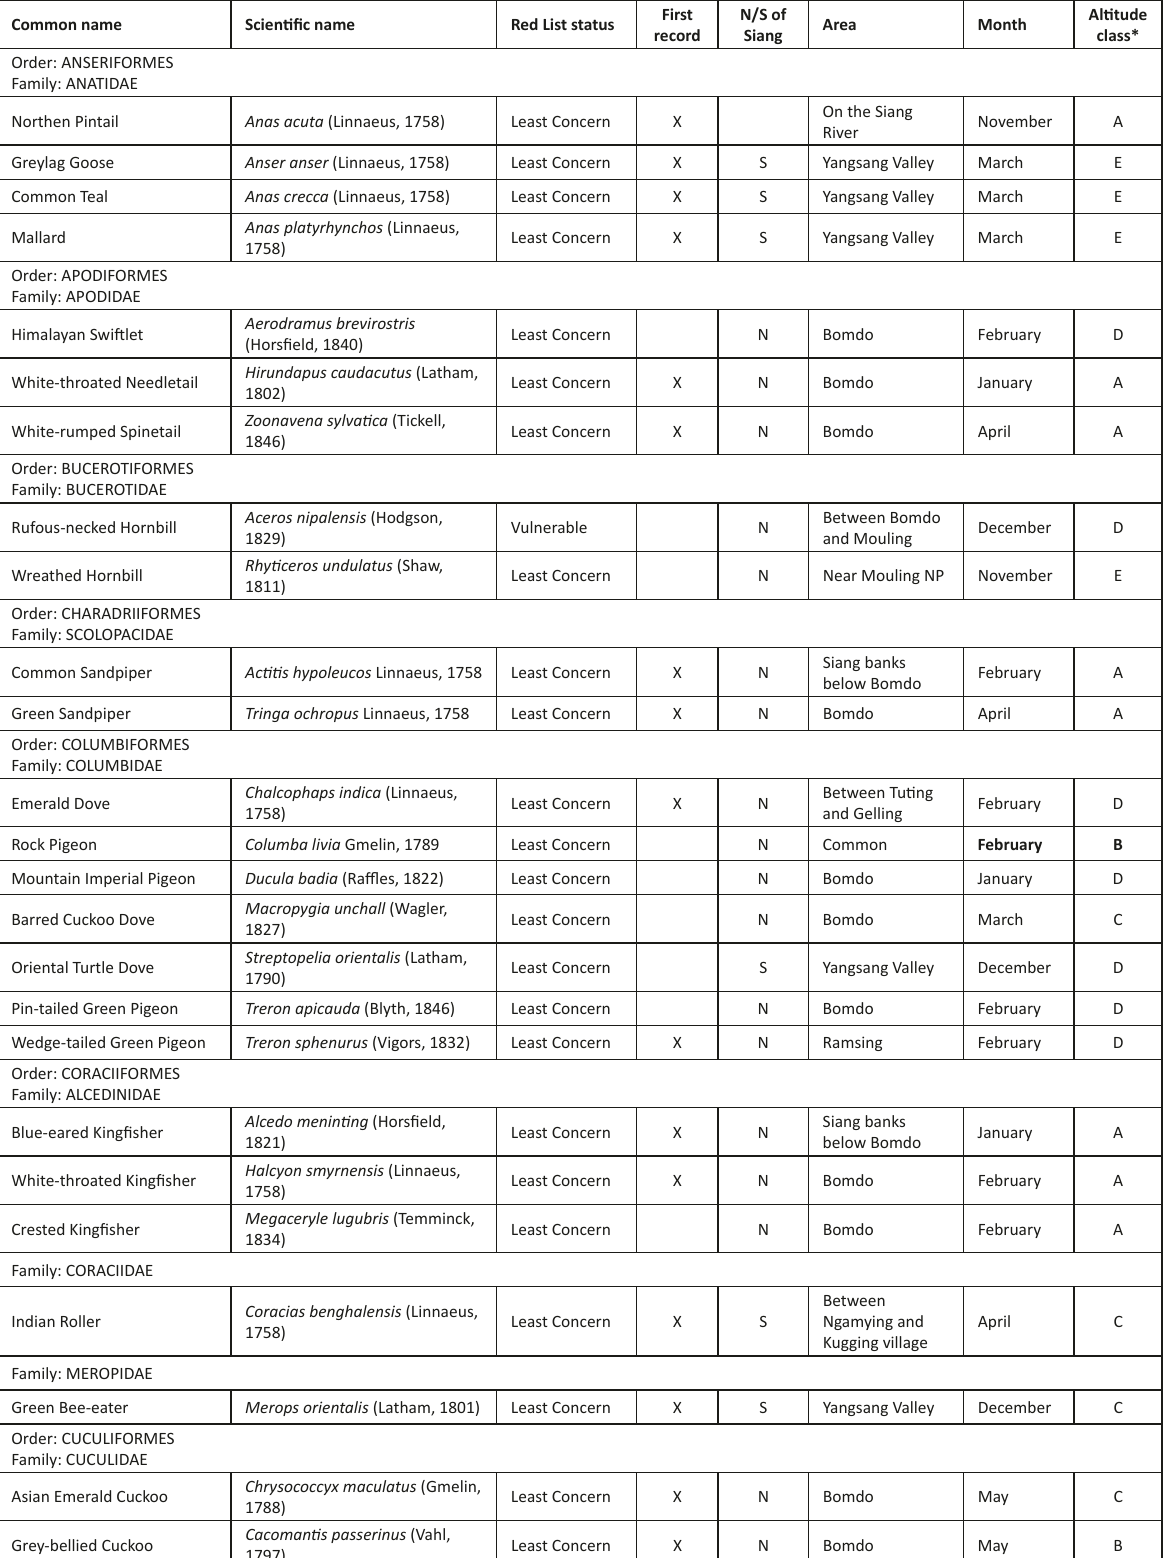
Table 1. Checklist of bird species, Red List status, indicator of first record, location relative to the Siang, time of year and altitude from the study area Common